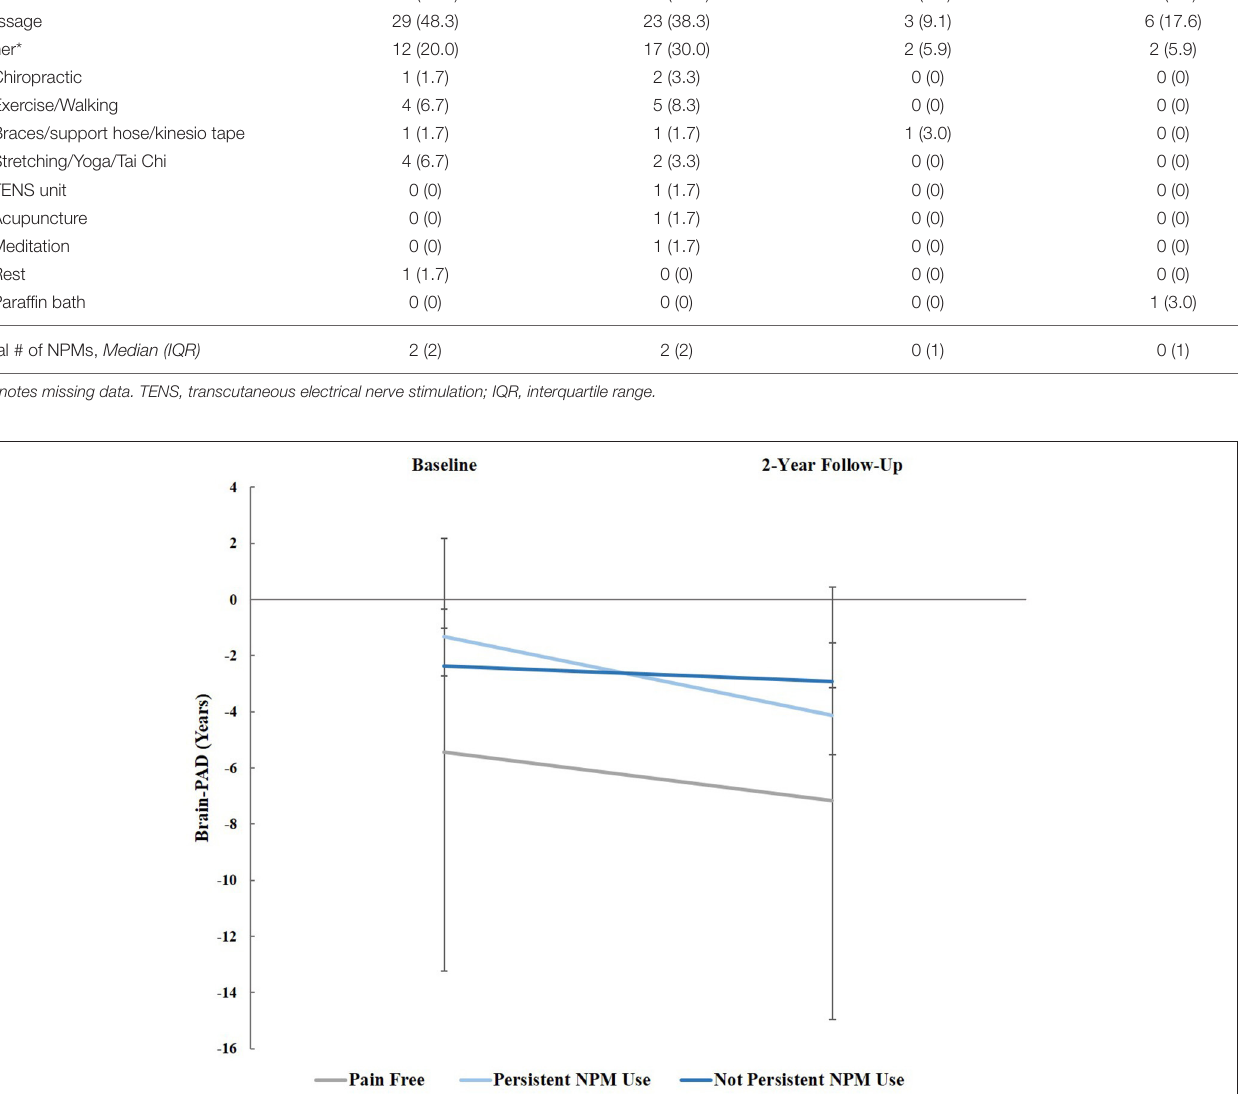
NPM, ( mean difference = 18.82 , Bonferroni corrected p =